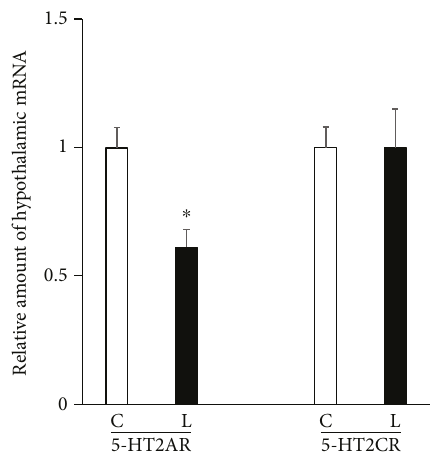
Figure 3: E ff ects of intraperitoneal injection of liraglutide (100 μ g/ kg) or saline on the expression of hypothalamic 5-HT2A receptors (5-HT2AR) and 5-HT2C receptors (5-HT2CR) in C57BL6J mice. C, saline controls; L, liraglutide-treated mice. Data are presented as the mean values ± SEM ( n = 6 /group of animals). ∗ P < 0 05